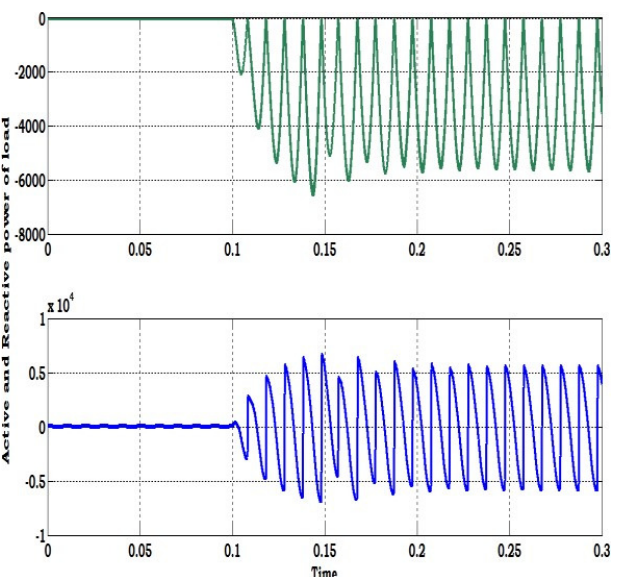
Figure 17. Waveform of Load Current